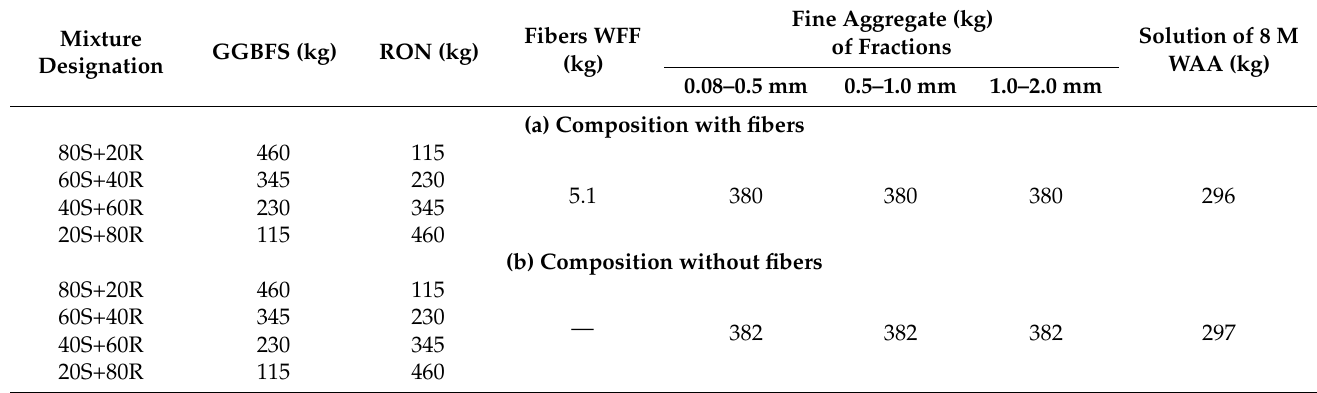
Table 2. Composition of 1 m 3 of the studied